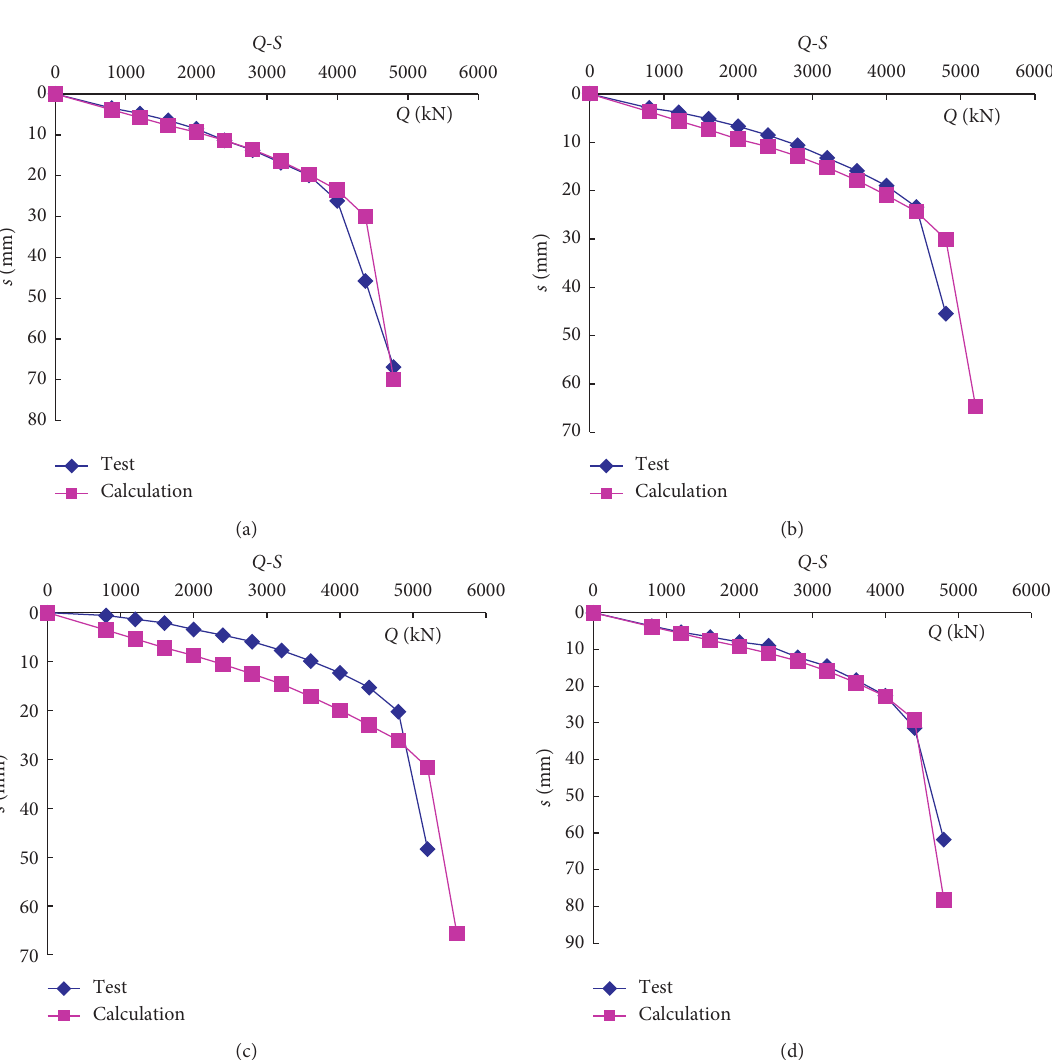
Figure 14: Comparing the results of numerical simulation and SLTs (at the hard rock bearing stratum site). (a) Pile #7. (b) Pile #8. (c) Pile #10. (d) Pile #11. Table 11: Results of numerical simulation and experimental testing of test piles at the soft rock bearing stratum site. Pile no.